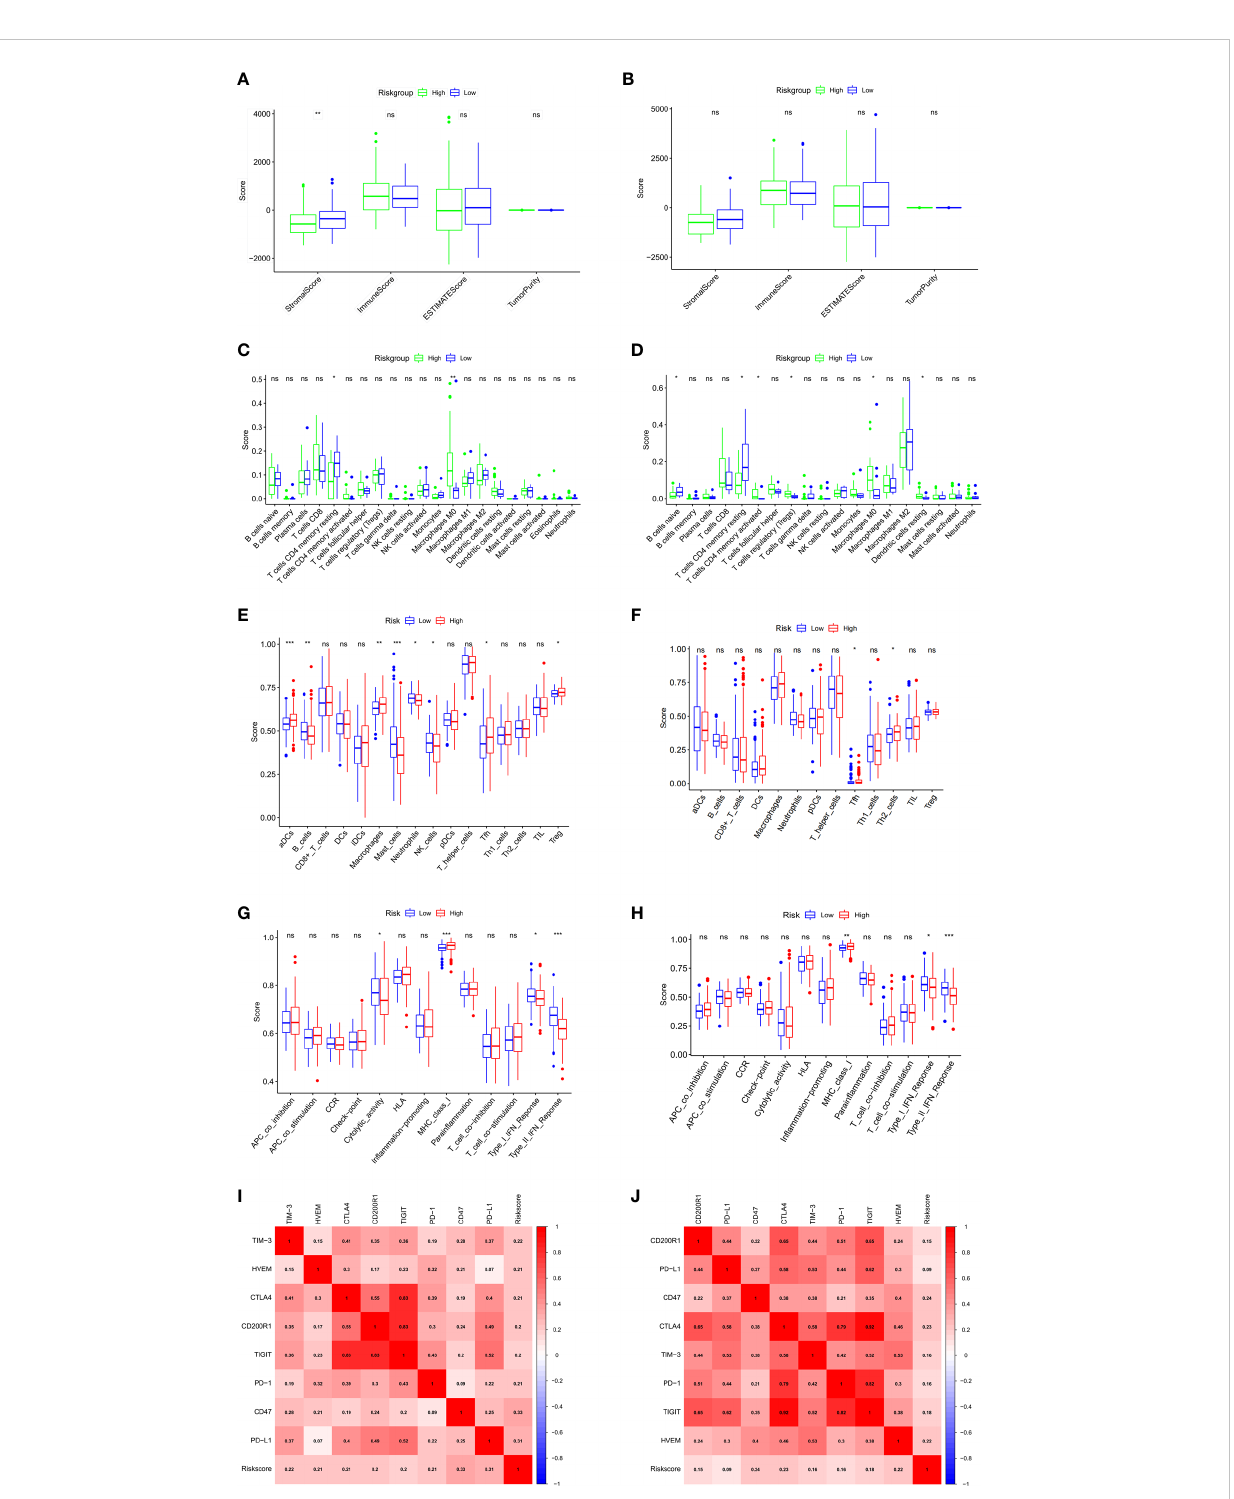
FIGURE 6 Evaluation of tumor microenvironment and immune checkpoints of anoikis-related prognostic signature. (A, B) Comparison between the estimate score, immune score, stromal score, and tumor purity based on risk groups in TCGA cohort (A) and ICGC cohort (B) . (C, D) Comparison between the subtypes of immune cells based on risk groups in TCGA cohort (C) and ICGC cohort (D) . (E, F) Immune cell in fi ltration analysis based on risk groups in TCGA cohort (E) and ICGC cohort (F) . (G, H) Immune-related pathways in fi ltration analysis based on risk groups in TCGA cohort (G) and ICGC cohort (H) . (I, J) The correlations between the risk score and the expression of the immune checkpoint genes in TCGA cohort (I) and ICGC cohort (J) . *p<0.05; **p<0.01; ***p<0.001; ns, not signi fi